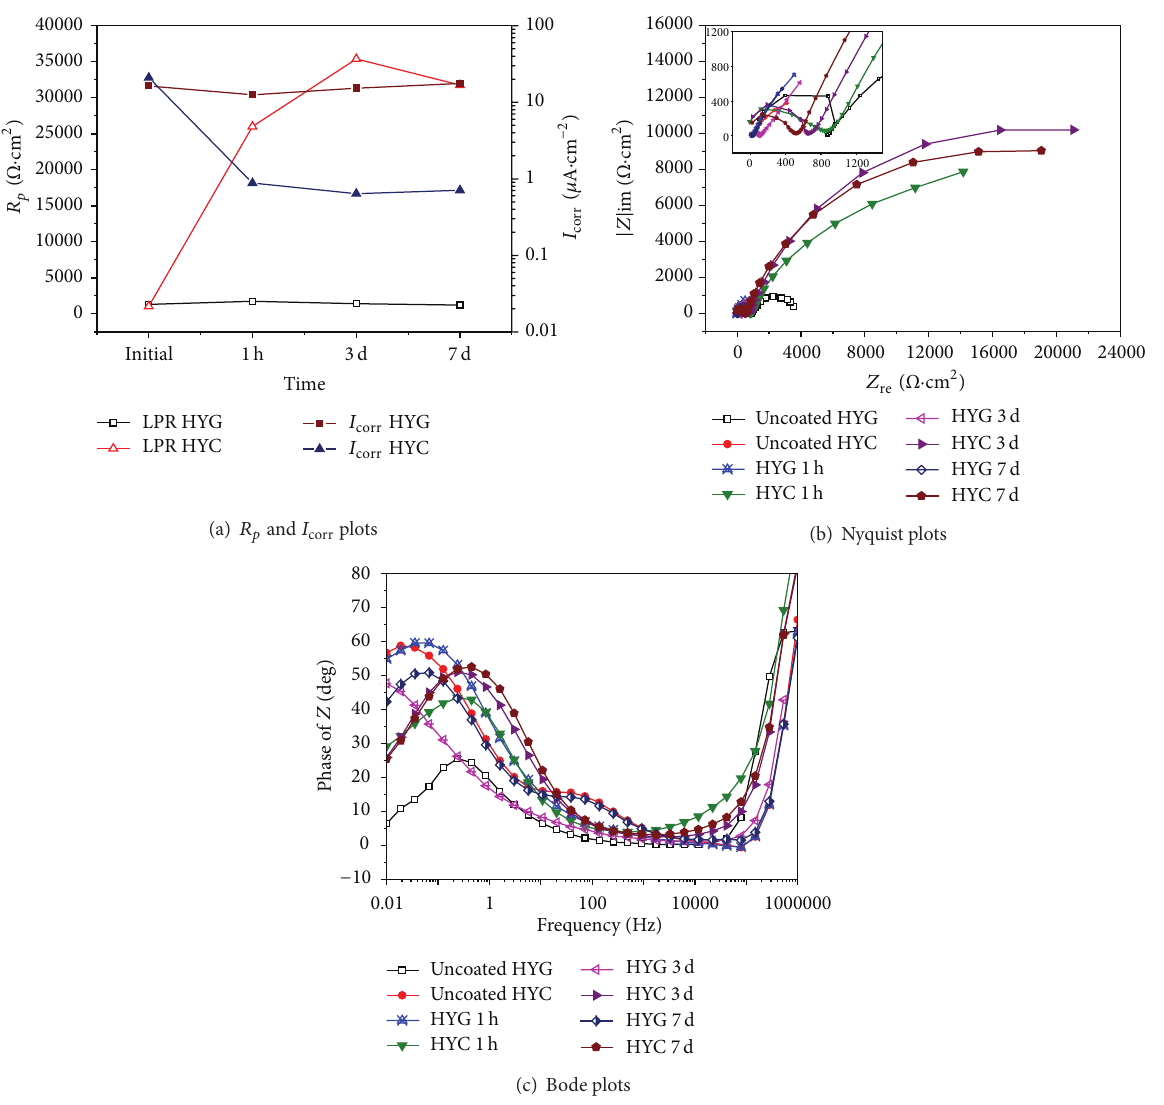
Figure 2: LPR and EIS plots of electrodes coated with HYG and HYC in chloride